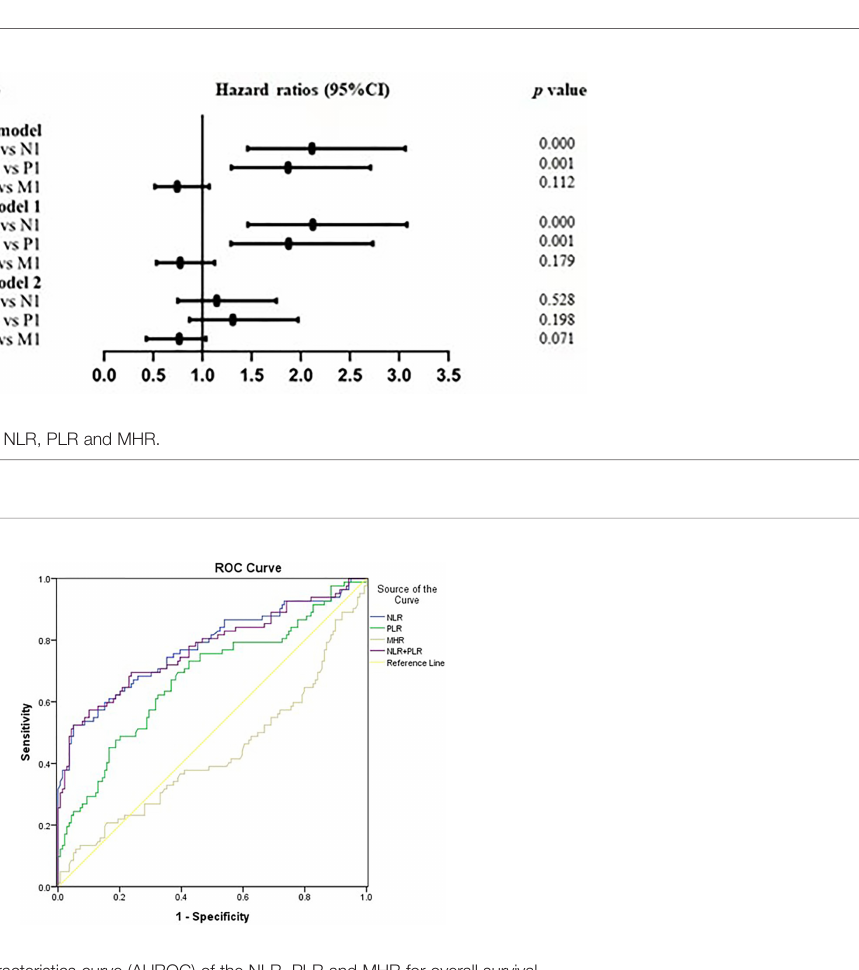
FIGURE 5 | Area under the receiver operating characteristics curve (AUROC) of the NLR, PLR and MHR for overall